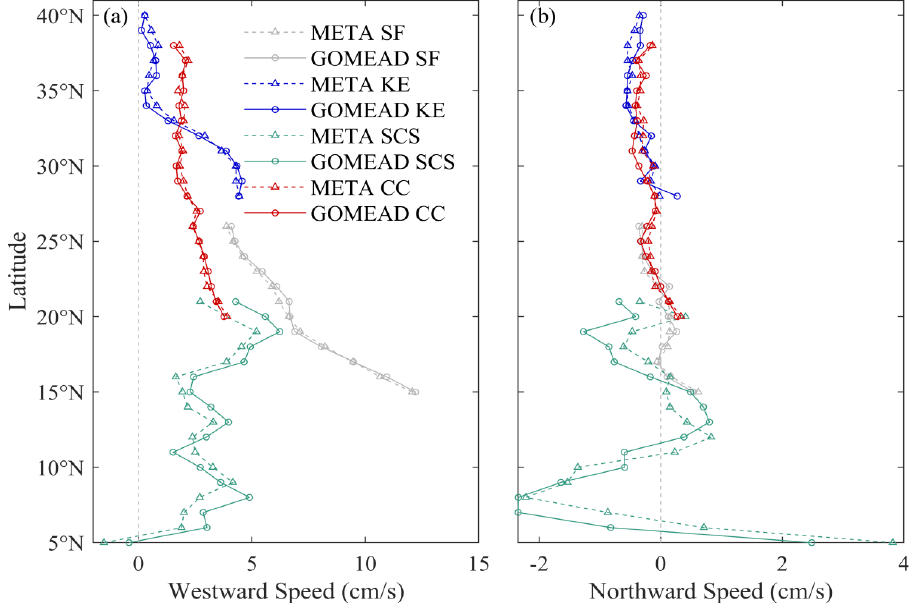
Figure 14. Variations of ( a ) westward speeds and ( b ) northward speed of AEs by latitude. Dashed and solid lines represent results from the META and GOMEAD datasets, respectively.